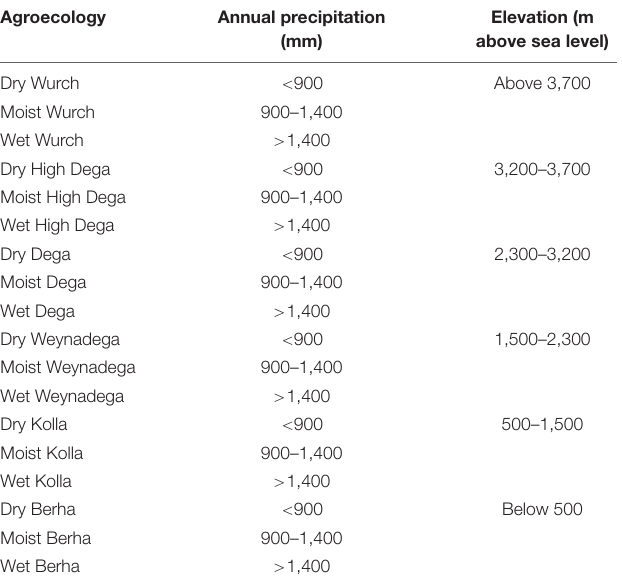
TABLE 2 | Characteristics of the traditional agroecological zones of Ethiopia.